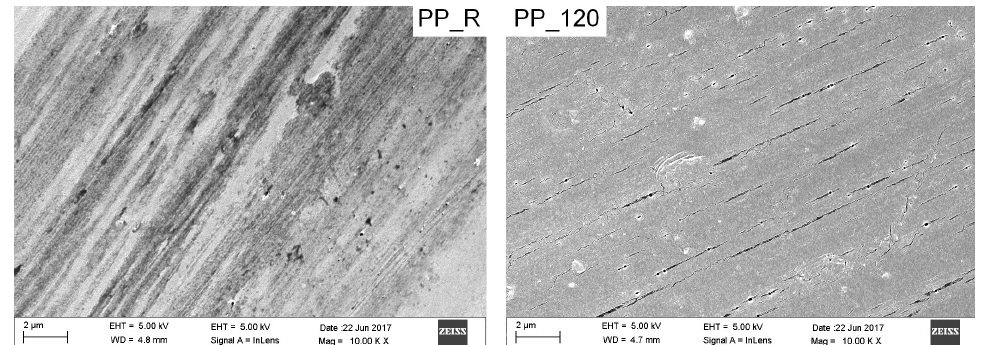
Figure 3. SEM images of reference (left) and modified (right) PP fiber.